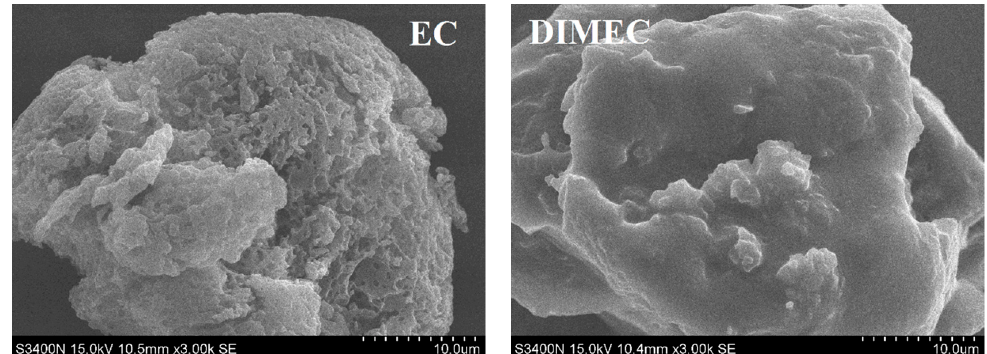
Figure 6. SEM micrographs of DIMEC and EC.